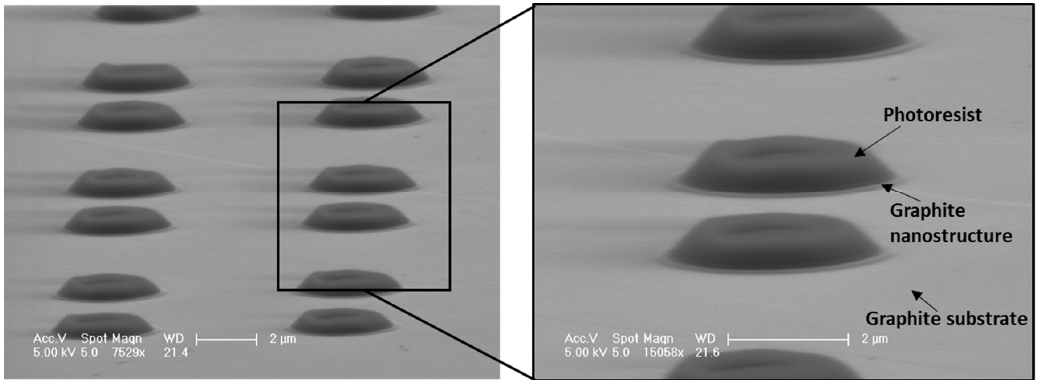
Figure 3. The electron micrograph of the etched photoresist and graphite microstructures by using scanning electron microscope.